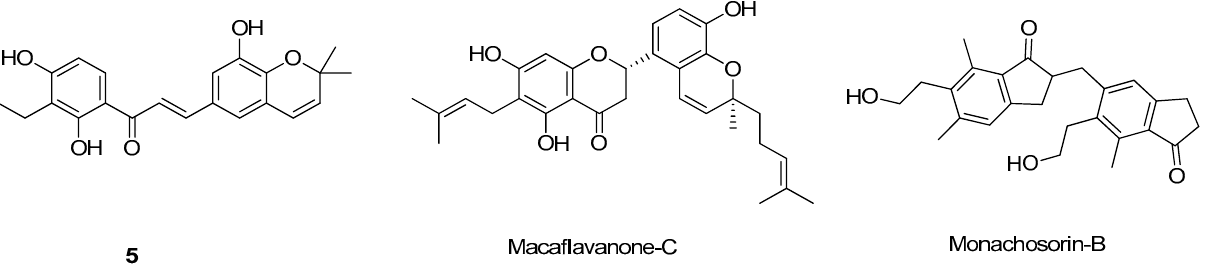
10 of 28 Figure 8. Structures of the studied BACE-1 inhibitors. 2.3.2. γ -Secretase γ -Secretase is a multi-subunit protease enzyme complex involved in APP cleavage in the amyloidogenic pathway into A β peptide [66]. This protein complex is composed of presenilins, 1- (PSEN-1) and 2- (PSEN-2), presenilin enhancer 2, anterior pharynx-defec-